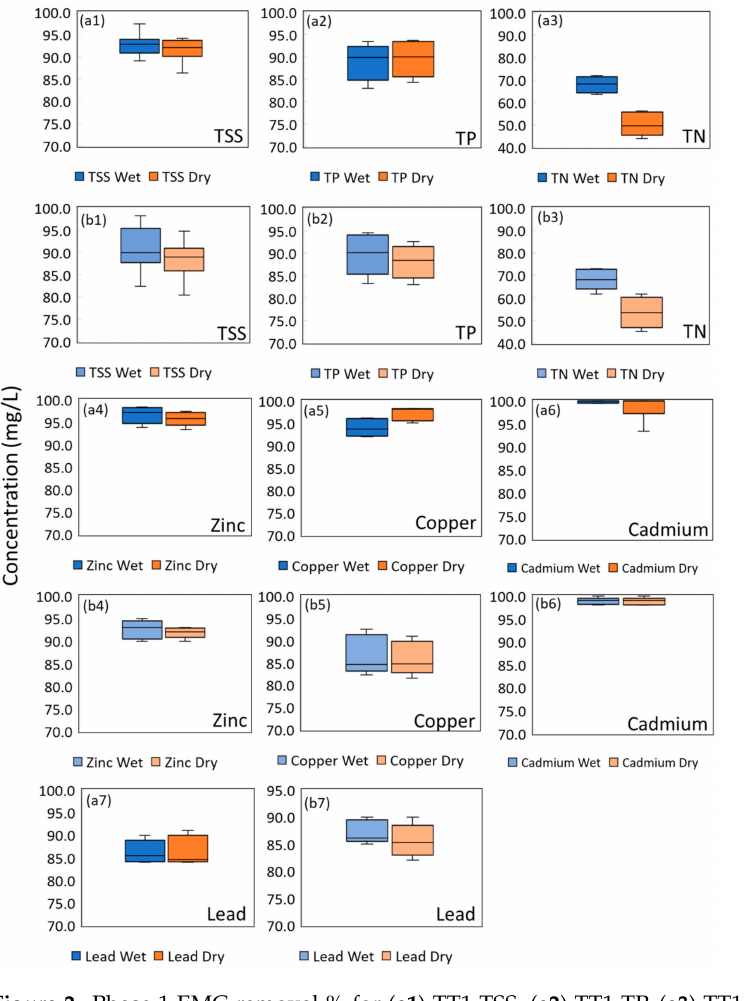
Figure 2. Phase 1 EMC removal % for ( a1 ) TT1 TSS, ( a2 ) TT1 TP, ( a3 ) TT1 TN, ( a4 ) for TT1 Zinc, ( a5 ) TT1 Copper, ( a6 ) TT1 Cadmium, ( a7 ) TT1 Lead, ( b1 ) EMC removal % for TT2 TSS, ( b2 ) TT2 TP, ( b3 ) TT2 TN, ( b4 ) TT2 Zinc, ( b5 ) TT2 Copper, ( b6 ) TT2 Cadmium, and ( b7 ) TT2